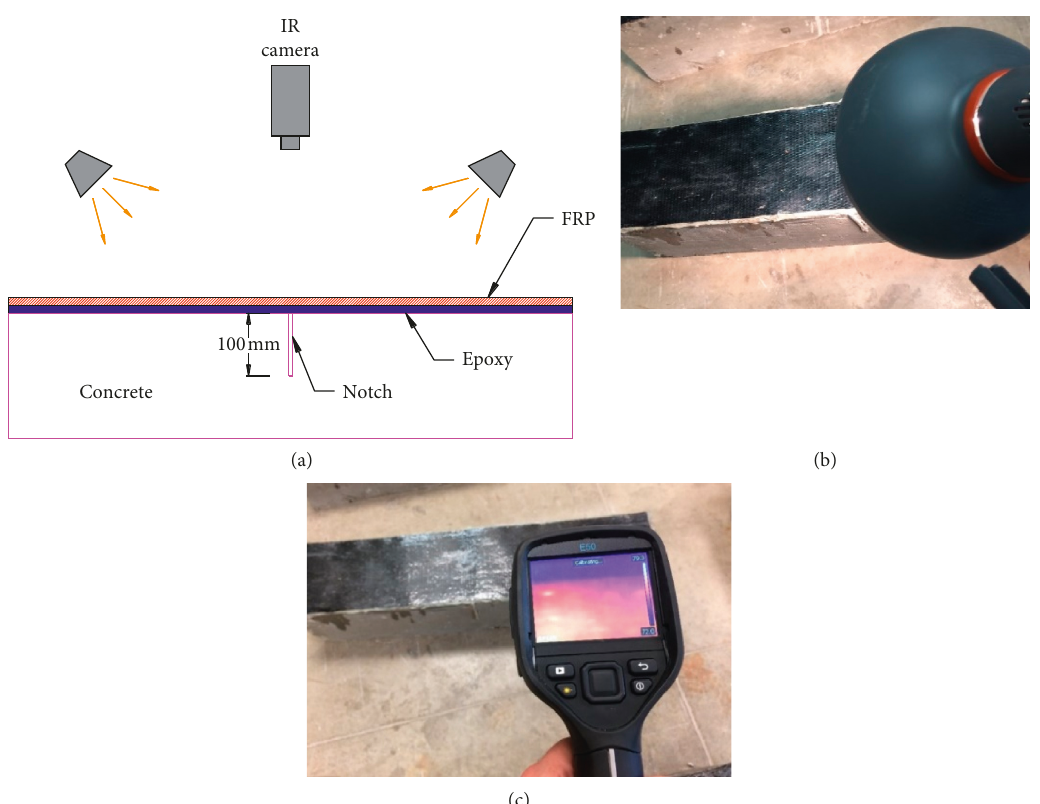
Figure 10: Thermography scanning. (a) Test schematic. (b) Surface heating. (c) Capturing thermograph